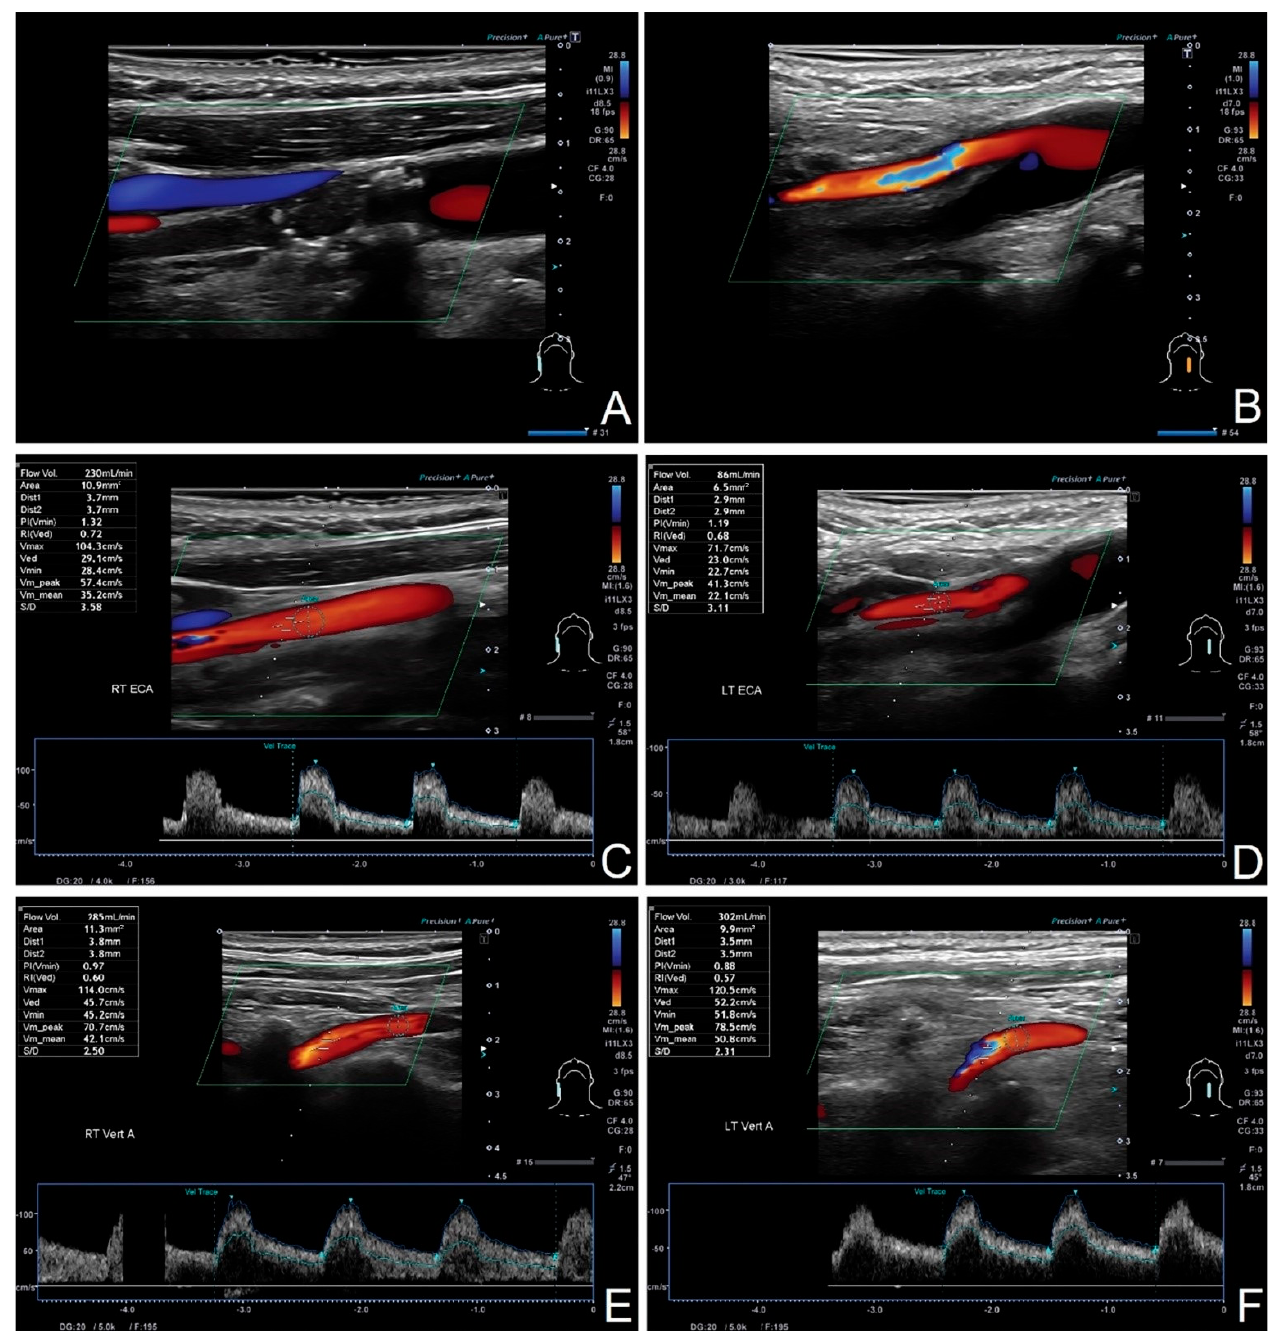
Figure 10. Compensation in patient with bilateral ICA occlusion. ( A ) Right-sided ICA occlusion; ( B ) left-sided ICA occlusion; ( C ) compensatory increased flow in RECA with flow volume of 230 mL/min; ( D ) flow volume in LECA of 86 mL/min; ( E ) compensatory increased flow in RVA with flow volume of 285 mL/min; ( F ) compensatory increased flow in LVA with flow volume of 302 mL/min. Flow was within the reference values despite bilateral CAO.